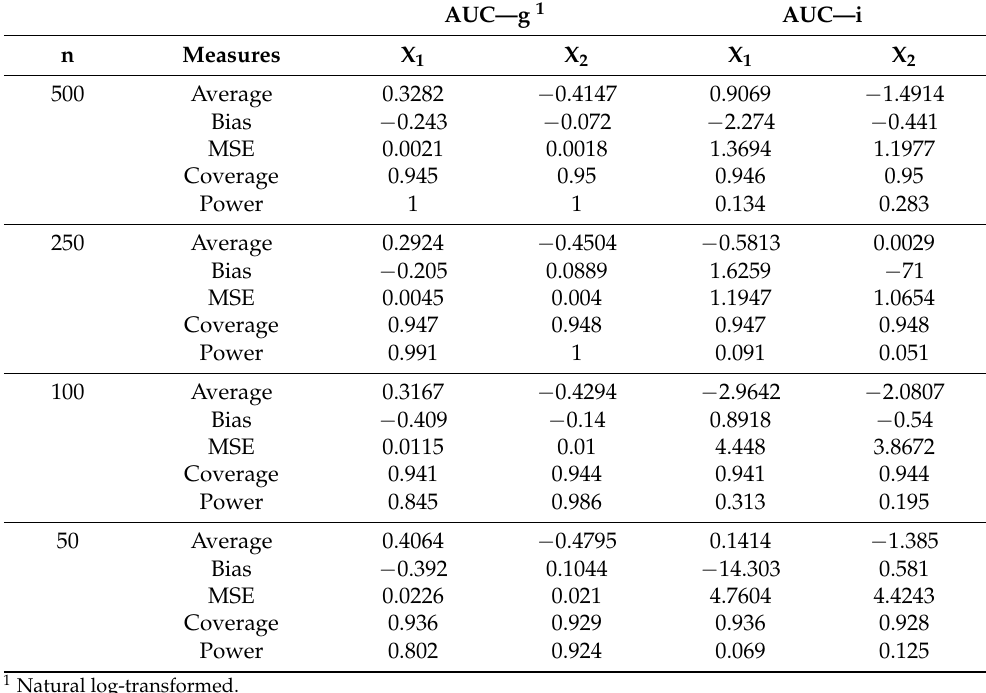
Table 4. Monte Carlo simulation regression results for AUC—g and AUC—i.